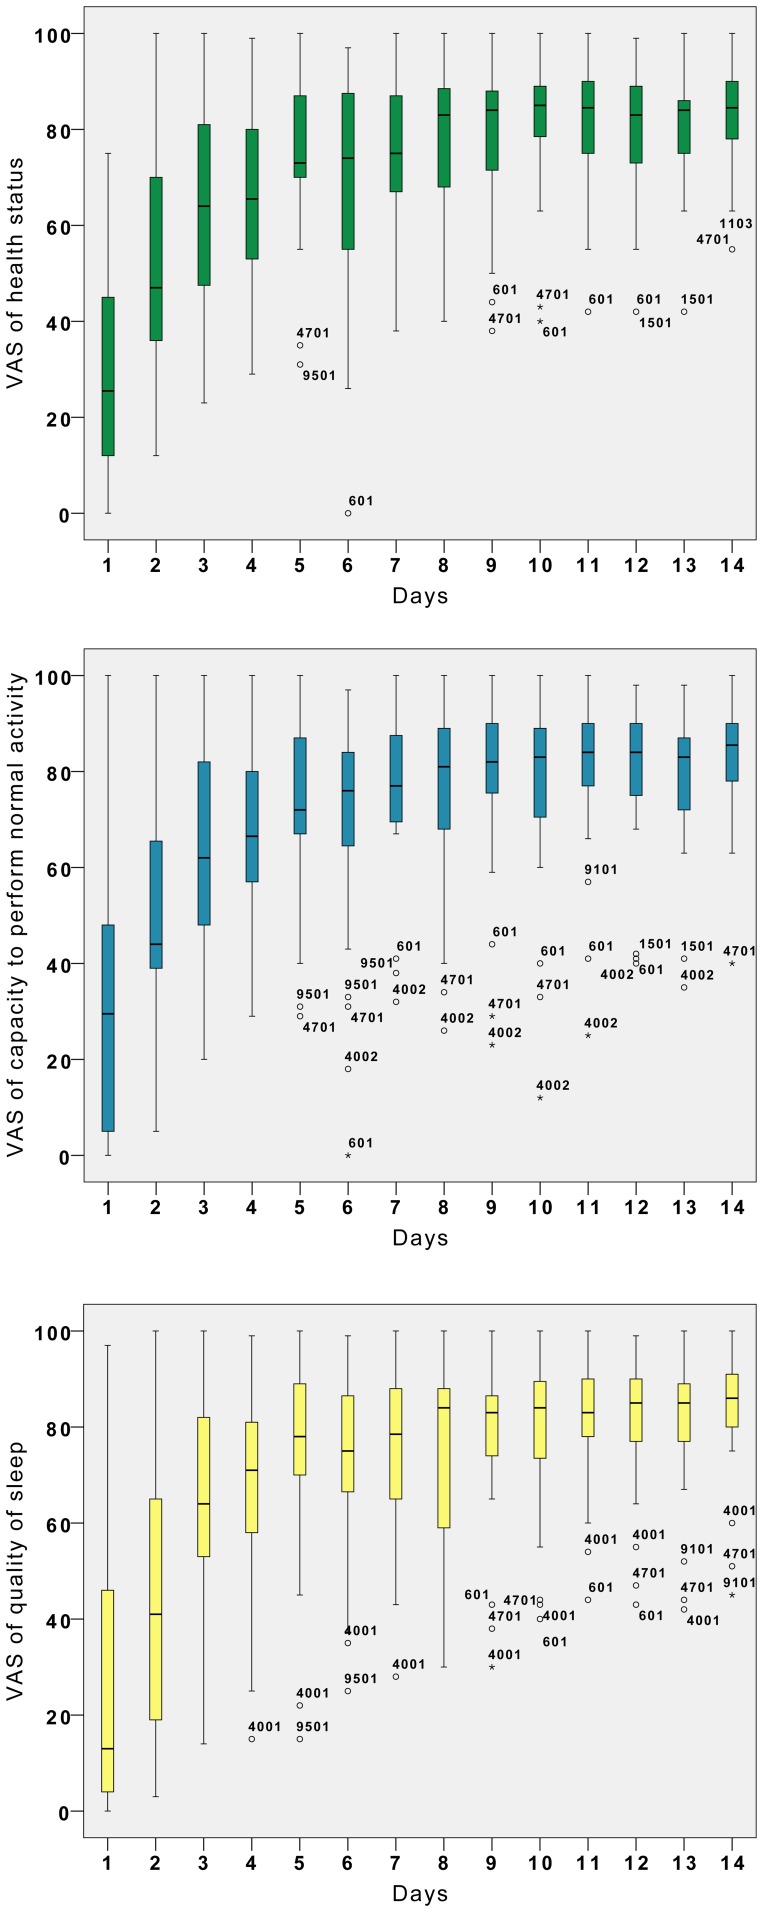
Quality of life assessed by ambulatory CHIKV+ve patients* from day 1 until day 14.Three kind of quality of life (health status, capacity to perform normal activity and quality of sleep) were assessed by self reported visual analogic scale (VAS) from “very bad” (VAS = 0) to “very good” (VAS = 100) and are represented here by box plot diagrams. Box plot is a representative diagram of continuous variables. The bottom and the top of the box are the 25th and 75th percentile, the band near the middle is the median and the ends of the whiskers are the 1.5 inter-quartile of the lower and upper quartile. The data not included between the whiskers are plotted as an outlier with small circles (if between 1.5 to 3 inter-quartile of the lower or upper quartile) or with a star (if higher than 3 inter-quartile of the lower or upper quartile). The outliers are tagged with their patient numbers to follow them at different time period. * Clinical assessment at D1 was obtained from all CHIKV+ve patients (N = 54) during the Reunion island outbreak 2005–2006. Only patients receiving placebo (N = 27) were included in D2–D14 clinical assessment.